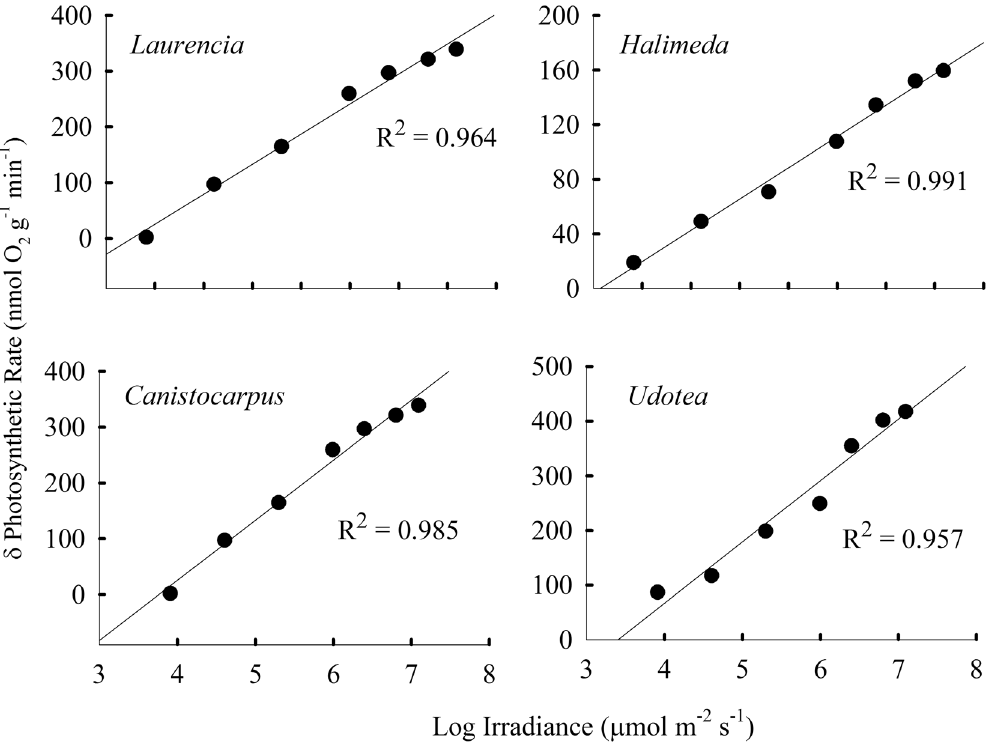
Figure 2. Linear relationship between the log of irradiance ( μ mol m − 2 s − 1 ) and the difference in photosynthetic rates at 8.5 and 7.5 pH for two species of fleshy (left panels) and calcified (right panels) tropical macroalgae with greater P gmax under OA conditions (Fig. 1). Data from PI curves shown in Fig.